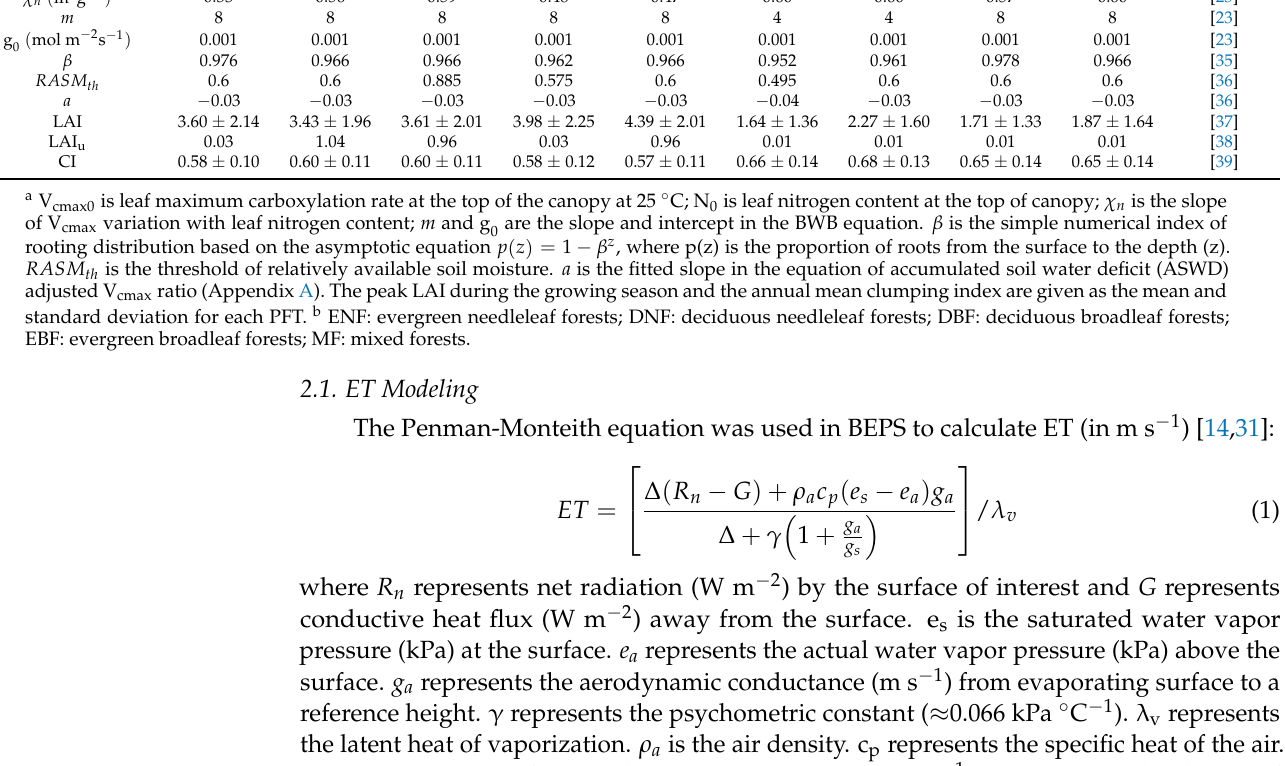
Table 1. Physiological and canopy structural parameters are used in the BEPS model for various PFTs. Parameters a Grass Crop Shrub Others